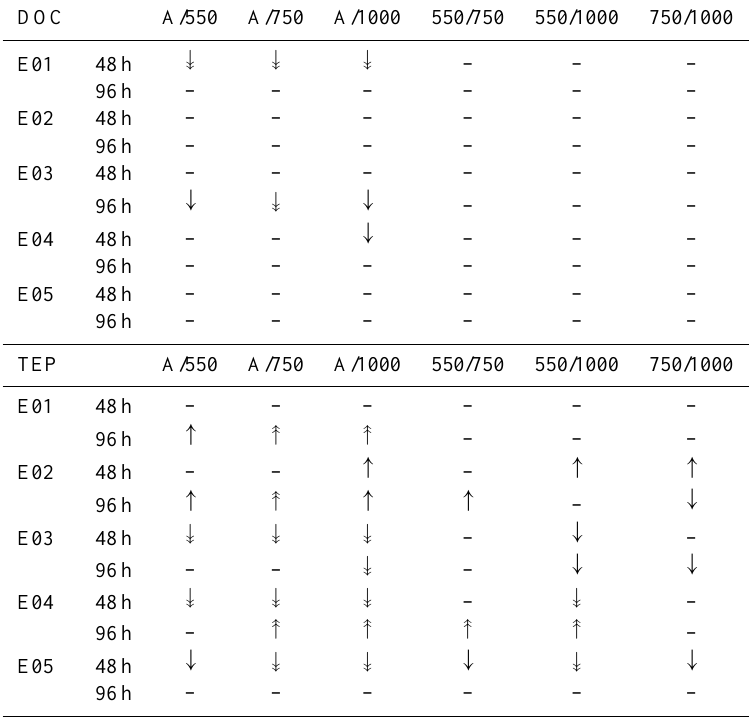
Table 1. Summary of statistically significant differences between treatments for DOC (top) and TEPs (bottom). Upward pointing arrows signify a positive correlation between p CO 2 and DOC/TEP production (more DOC/TEPs in the higher p CO 2 treatment) and downward pointing arrows signify a negative correlation (more DOC/TEPs in the lower p CO 2 treatment). Single-headed and two-headed arrows signify statistical significance at the 95% and 99% confidence level respectively (using the Tukey–Kramer test statistic); “–” signifies that treatments were not significantly different at the 95% confidence